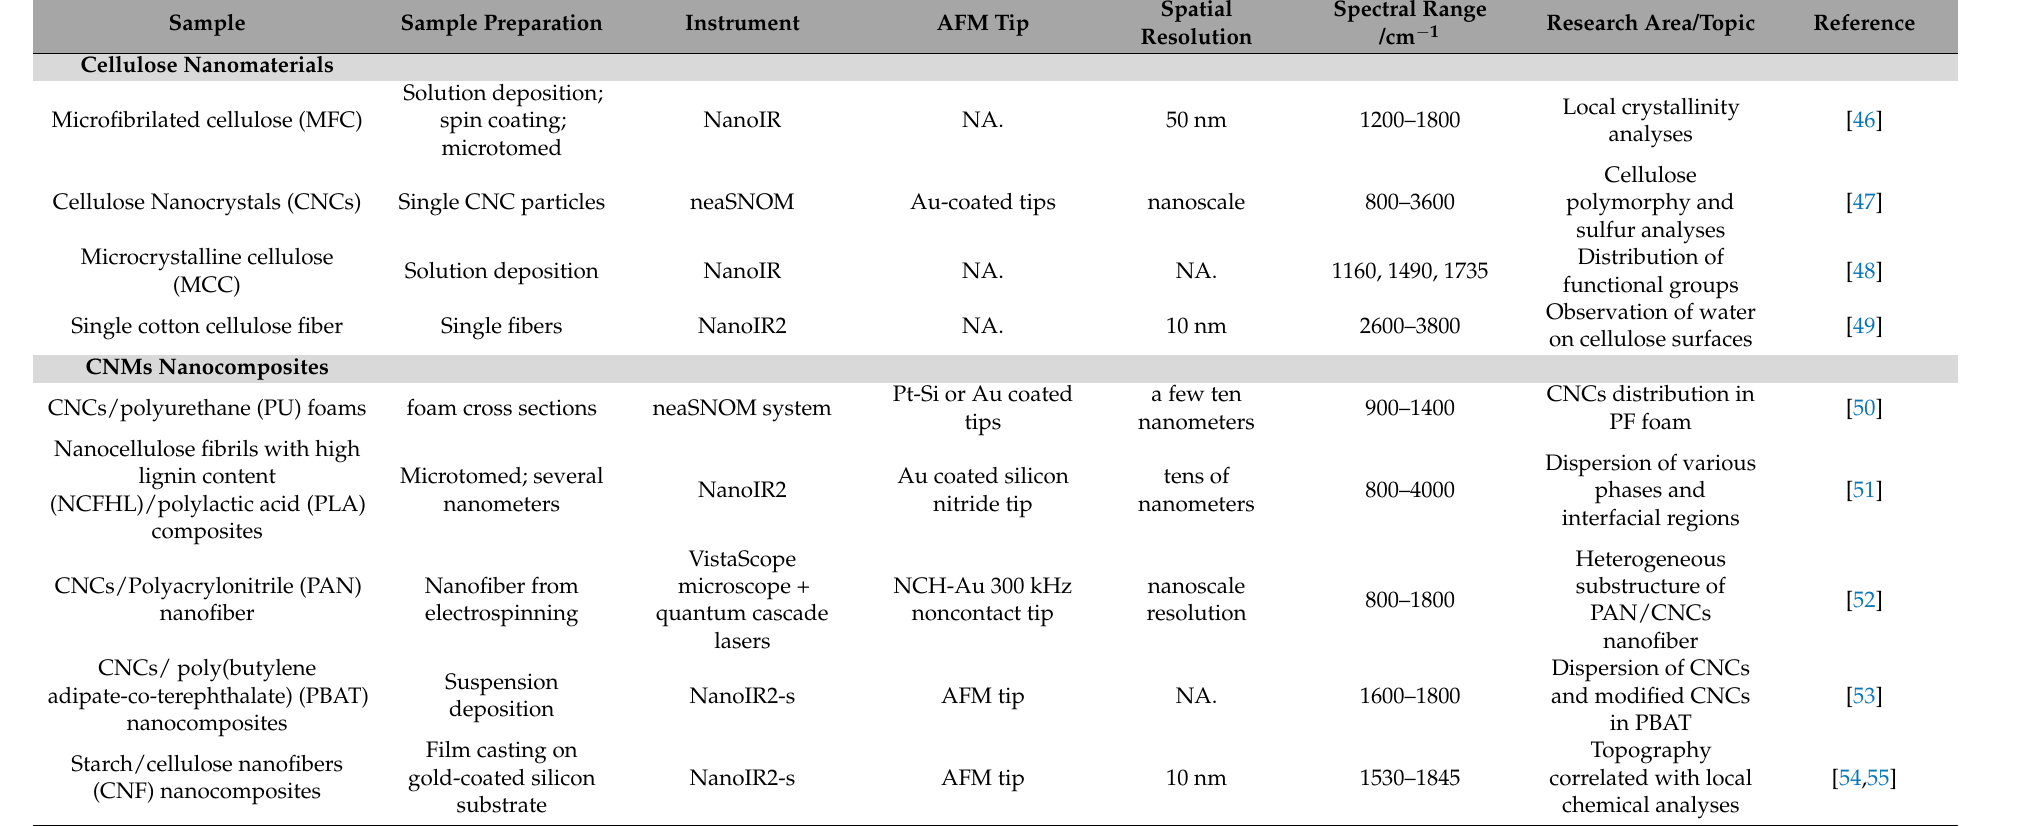
Table 2. Application of AFM-IR and IR s-SNOM for the characterization of cellulose